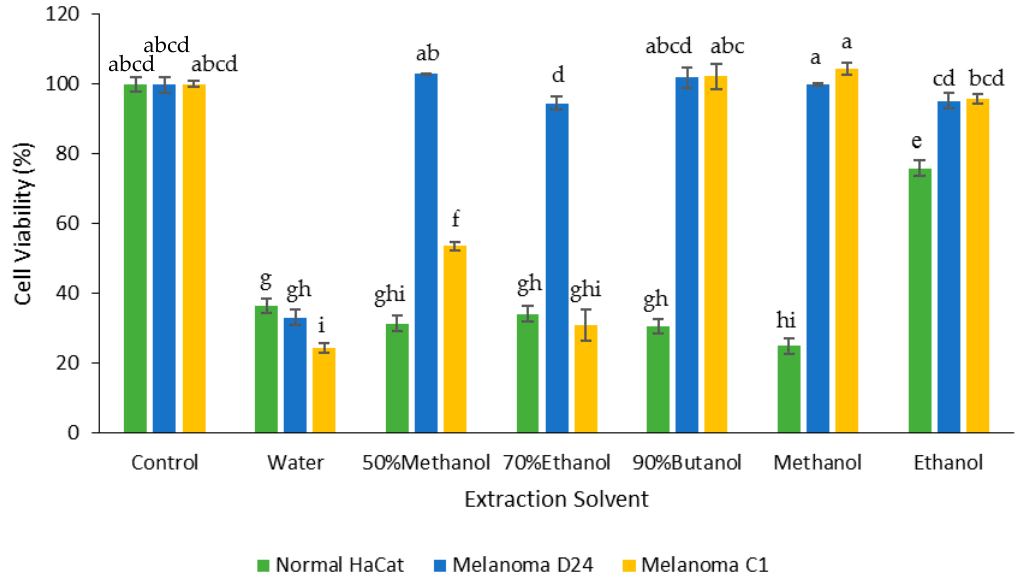
Figure 6. Effect of the FD crude extracts prepared with the different solvents on the cell viability of normal (HaCat) and melanoma (D24 and C1) cell lines after 48 h treatment. The values were the means ± SD of three replicate extractions for each solvent. Columns not sharing the same letter were significantly different at p < 0.05.